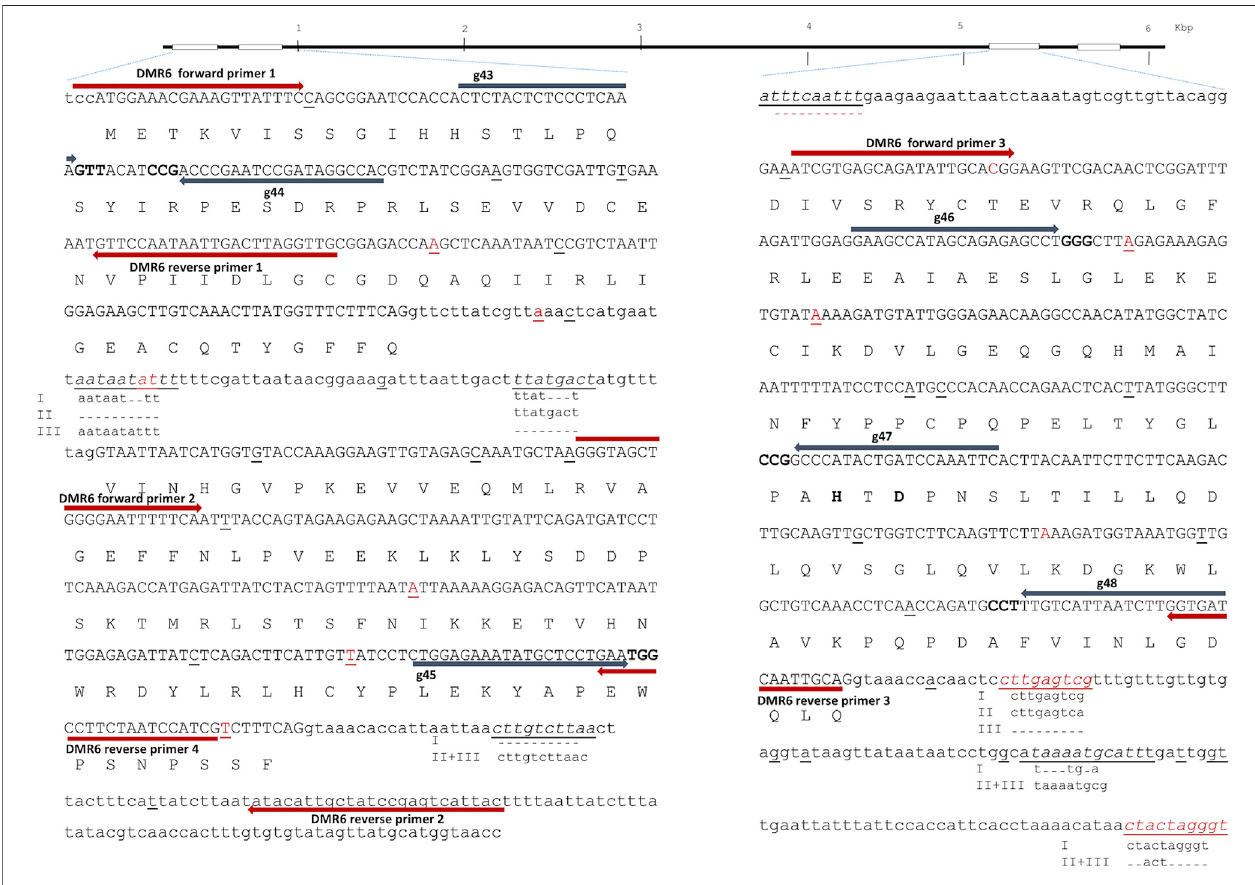
FIGURE 2 | Downey Mildew Resistant (DMR) 6 — structure and full allelic sequence of gRNA target regions. Overall gene structure with exons (boxes) is depicted above. Left: the nucleotide sequence of exon 1 and 2 with introns. Right: Exon 3 including introns. Exons are depicted in capital letters with the amino acid sequence indicated. Small nucleotide polymorphisms (SNPs) from cultivars included in the SPUD database are marked with red, and SNPs found in Wotan are underlined. Grey arrowsdesignategRNAs(g43,g44,g45,g46,g47,andg48)withPAMsitesmarkedinbold.RedarrowsdesignatediagnosticIDAAPCRprimers.Twoofthethree catalytic residues histidine H212 and aspartic acid D214 marked with bold. The last catalytic residue H269 located in exon 4 is outside of the fi gure.